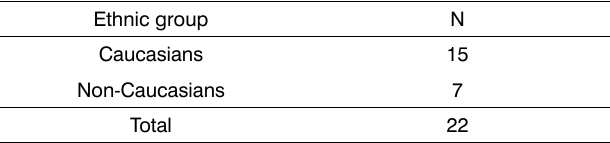
Table 1. Description of blocks according to the ethnic group: